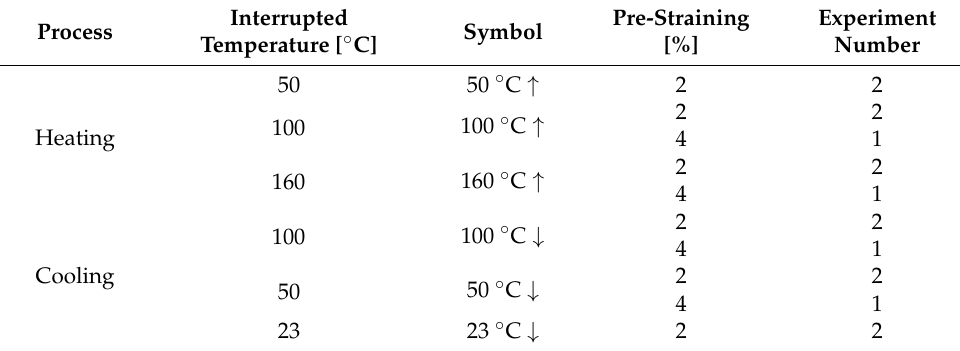
Table 1. List of pre-straining and interrupted thermomechanical experiments. The target temper- atures of interrupted thermomechanical experiments are 50 ◦ C ↑ , 100 ◦ C ↑ , and 160 ◦ C ↑ during heating, and 100 ◦ C ↓ , 50 ◦ C ↓ , and 23 ◦ C ↓ during cooling (‘ ↑ ’ and ‘ ↓ ’ indicate that the thermal cycle was interrupted during heating ‘ ↑ ’ or cooling ‘ ↓